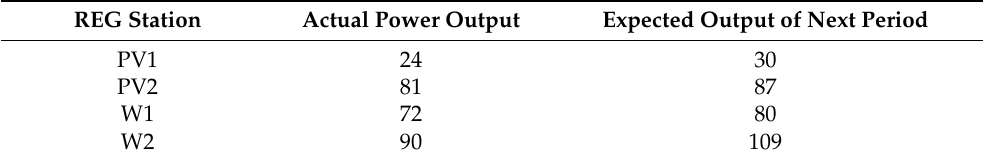
According to the prediction error model of each REG station (detailed data is in Appendix A), the probability density function of the predicted REG power error was obtained, as shown in Figure 6.